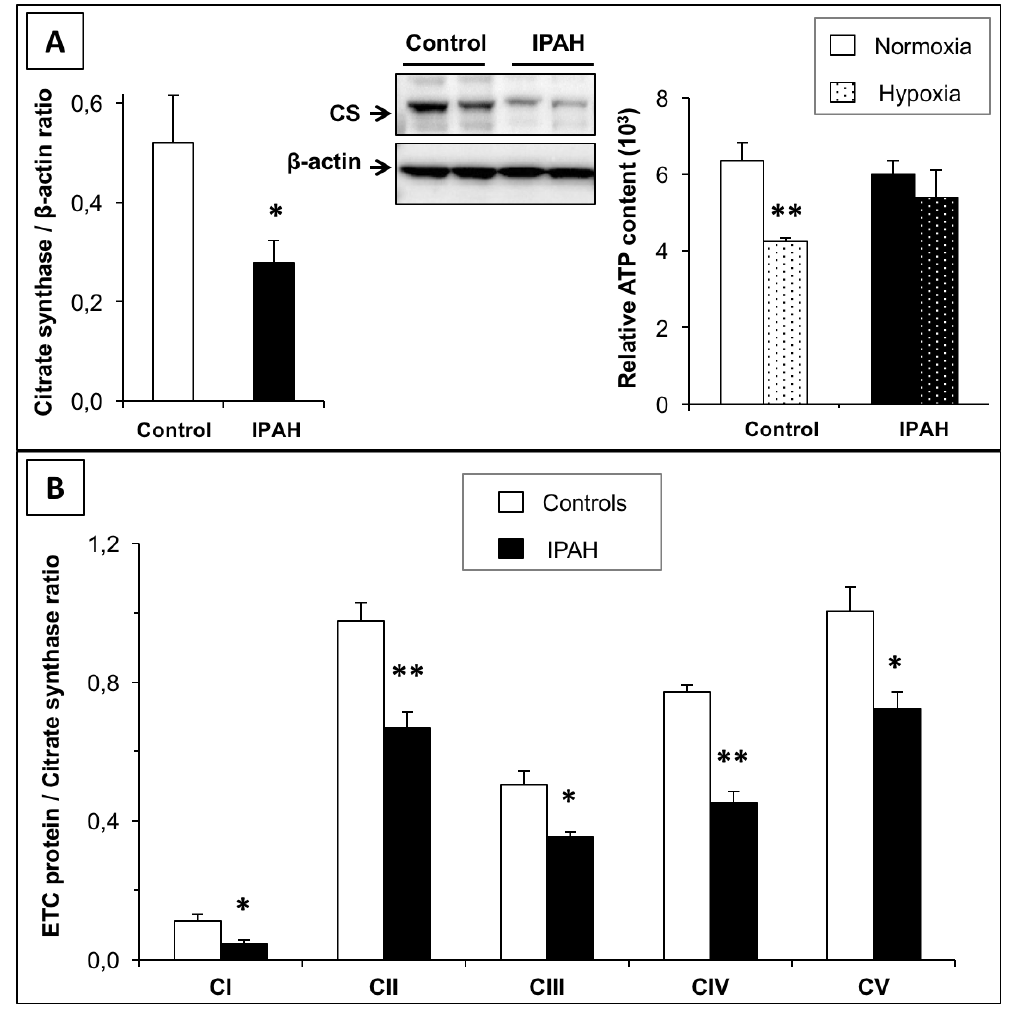
Figure 4. Energetic metabolism shift from mitochondrial respiration to glycolysis in IPAH. ( A ) Citrate synthase protein expression was lower in IPAH-PASMCs than in C-PASMCs. Measurement of ATP content in C-PASMCs and IPAH-PASMCs maintained for 24 h in normoxia (21% O 2 ) or hypoxia (2% O 2 ) (n = 5 in each group). ( B ): The levels of mitochondrial electron transport chain components were measured. The levels of different proteins were normalized against citrate synthase. * p < 0.05 and ** p < 0.01 between controls and IPAH.